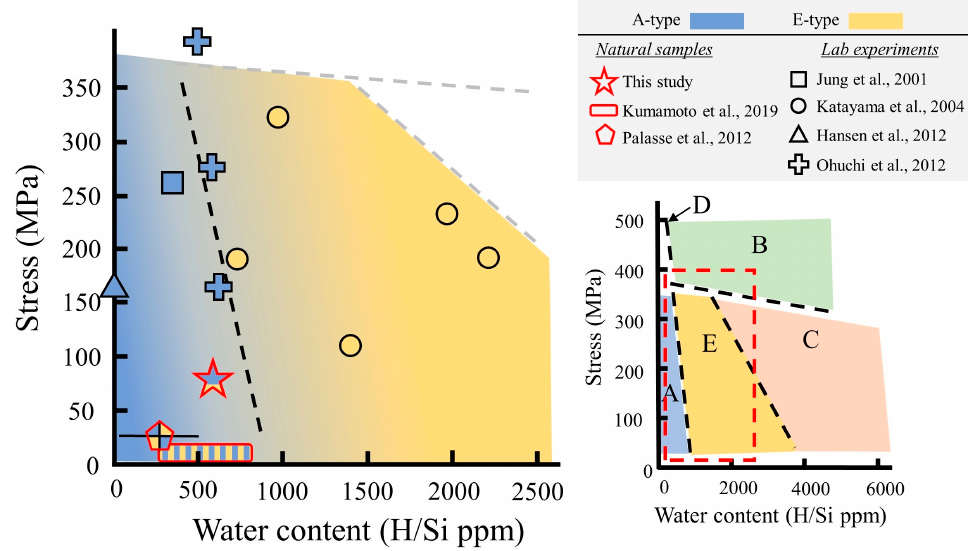
Figure 9. Stress versus C OH plot showing conditions for olivine A-type and E-type fabric regimes [60]. Sample H69-15F is shown as a red star. Points from the literature are shown (see legend) delineated by the black (for lab studies) and red (for natural samples) outlines. Water content is shown using the Bell et al. [70] calibration (a constant of 3.5 was used when the Paterson [71] calibration was originally used). Inset, classification of olivine crystallographic preferred orientation types on a plot of stress and water content, after Karato et al. [27]; the red box delineates the condition shown on the left side.